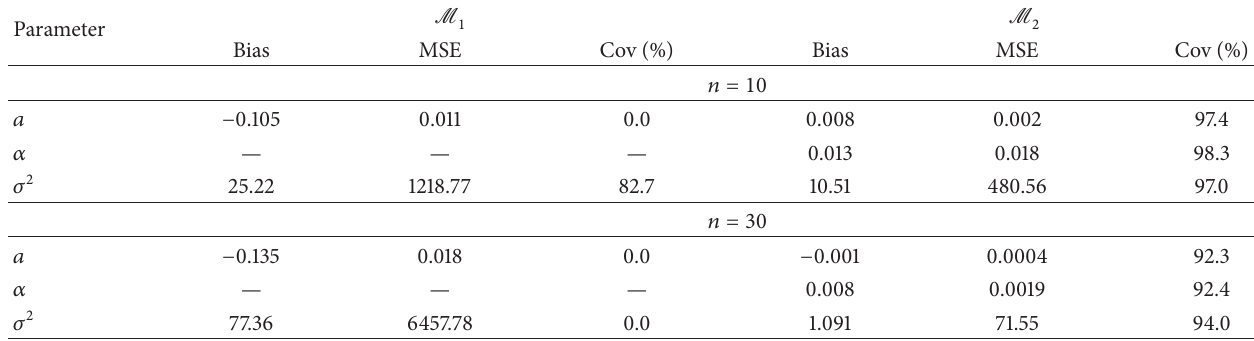
Table 1: Estimated Bias, MSE, and coverage, with 𝑋 0 known.